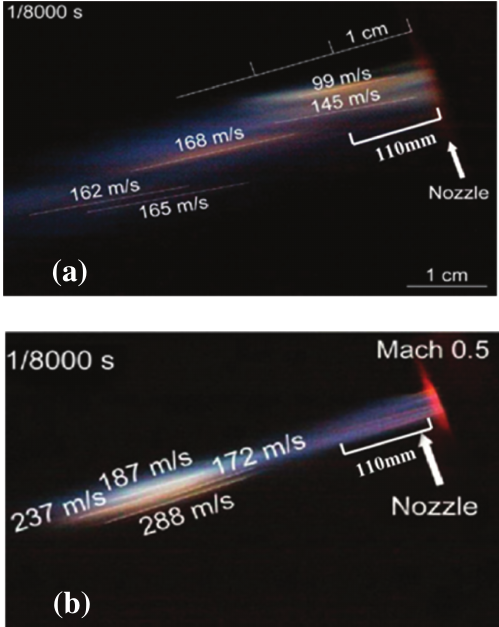
Figure 11: Representative photograph of the particle velocity (a) Mach 0.3 and (b) Mach 0.5